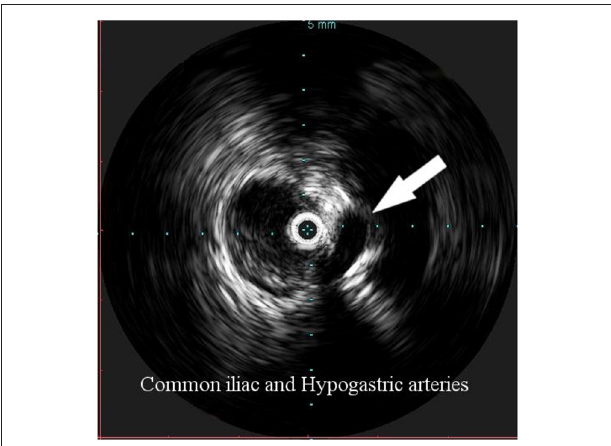
FIGURE 3 | Intravascular ultrasound (IVUS) identification of the hypogastric artery offspring (arrow), in order to identify the distal landing zone of the